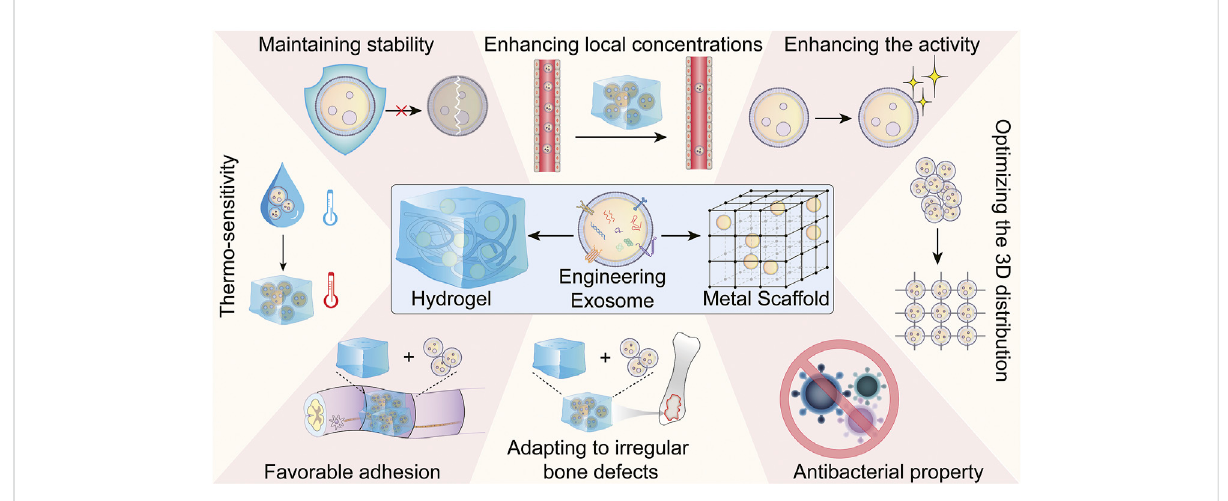
FIGURE 3 The properties of biomaterial (hydrogel and metal scaffold) help exosomes to promote bone